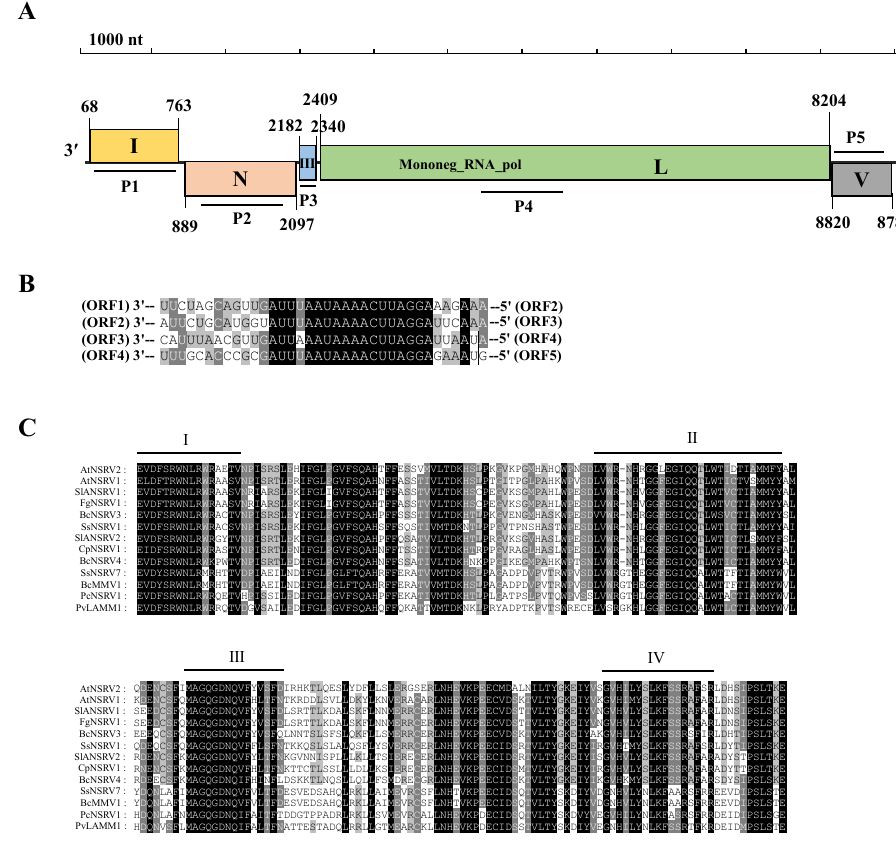
Figure 5. AtNSRV2 genomic organization. ( A ) Organization and genome size, and a conserved domain in the L protein. Boxes on the genome indicate the position and size of each ORF, which are labeled with Roman numerals, except for two ORFs, N and L, which encode the nucleoprotein (N) and RNA dependent RNA polymerase (RdRp) protein (L). ( B ) Putative gene junction regions among the ORFs in AtNSRV2. Alignment of the putative gene junction sequences is shown in a 3′ -to- 5′ orientation. ( C ) Amino acid sequence alignment of core RdRp motifs of AtNSRV2 and selected viruses from the genus Sclerotimonavirus . Conserved sequences are highlighted in black. Black highlights indicate the conserved sequences, shading indicates the conserved sequence levels, and the darkest color indicates the most conserved sequence. For abbreviations of virus names and viral protein accession numbers used in alignment analysis, see Supplementary Table